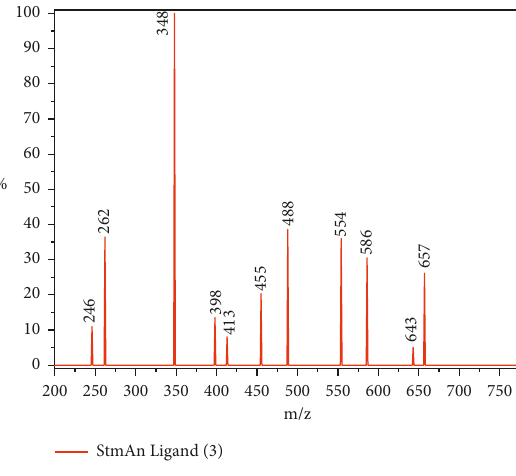
Figure 3: Mass spectrum of ligand ( 3